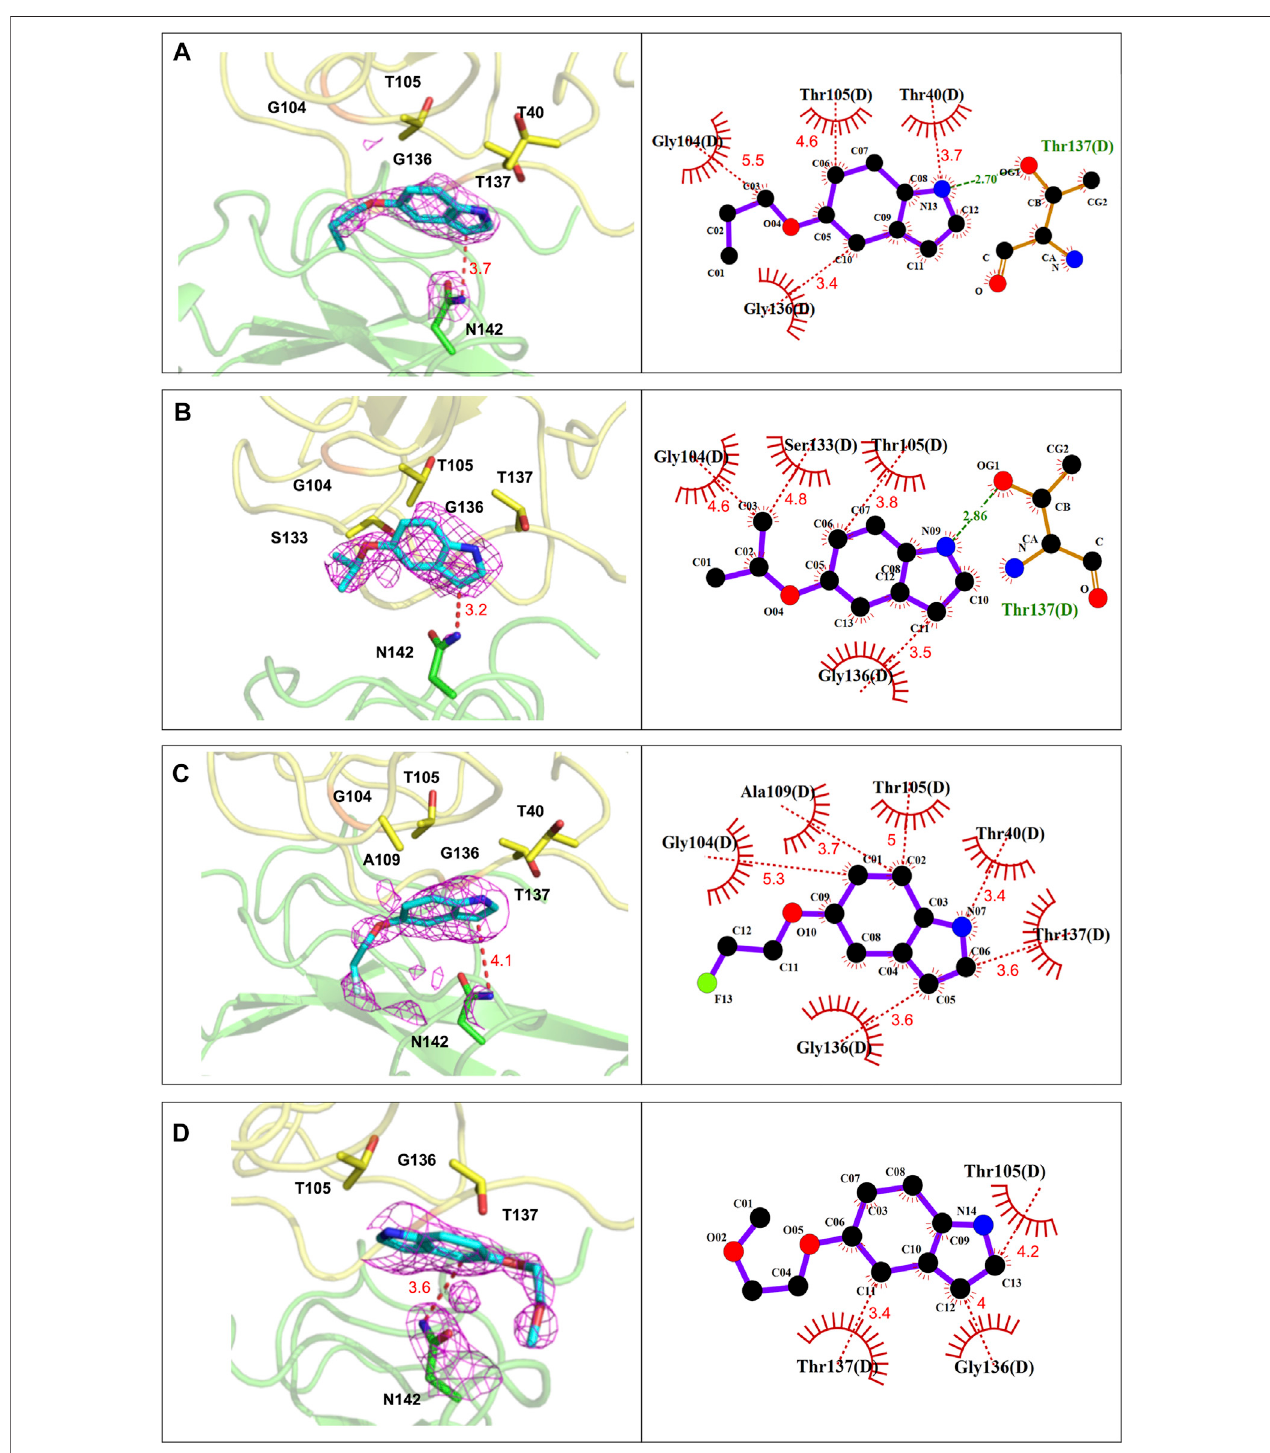
FIGURE4| ThedetailedinteractionsbetweenCoVN-NTDandeachcompoundatP4-bindingsite.(Left)TheCoVNproteinwasshownincartoonandtheresidues involved in ligand binding were labeled and showed as sticks. (Right) Ligplot diagram of the interactions between N-NTD and P4 compounds. The contacting residues were labelled. Hydrophobic contacts and hydrogen bonds were displayed as red and green dashed lines, respectively. (A) The interactions of P4-1 complex. (B) The interactions of P4-2 complex. (C) The interactions of P4-3 complex. (D) The interactions of P4-4 complex.